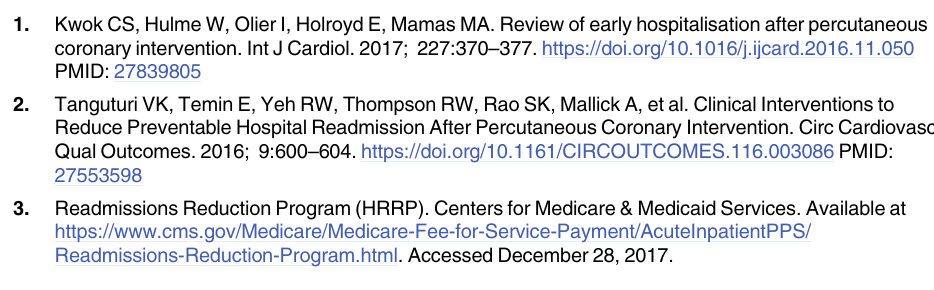
S2 Table. Complete list of reasons for readmission. Data are shown as n (%) except where otherwise noted. CABG, coronary artery bypass graft surgery; CRT, cardiac resynchronization therapy; ICD, implantable cardioverter-defibrillator; MSK, musculoskeletal; NSTEMI, non- ST-segment elevation myocardial infarction; OAC, oral anticoagulant; PCI, percutaneous cor- onary intervention; STEMI, ST-segment elevation myocardial infarction; TIA, transient ische- mic attack; URI, upper respiratory tract infection. S3 Table. BARC classification of all bleeding events in readmitted patients. Data are shown as n (%). BARC, Bleeding Academic Research Consortium; OAC, oral anticoagulant. S4 Table. Outcomes of patients on OACs during readmission, stratified by chronicity of OAC use. Data are shown as n (%) except where otherwise noted. CABG, coronary artery bypass graft surgery; CRT, cardiac resynchronization therapy; ICD, implantable cardioverter- defibrillator; MSK, musculoskeletal; NSTEMI, non-ST-segment elevation myocardial infarc- tion; OAC, oral anticoagulant; PCI, percutaneous coronary intervention; STEMI, ST-segment elevation myocardial infarction; TIA, transient ischemic attack; URI, upper respiratory tract infection. S5 Table. Medication regimens for patients discharged on oral anticoagulant therapy and readmitted. Data are shown as n (%). ASA, aspirin; OAC, oral anticoagulant.